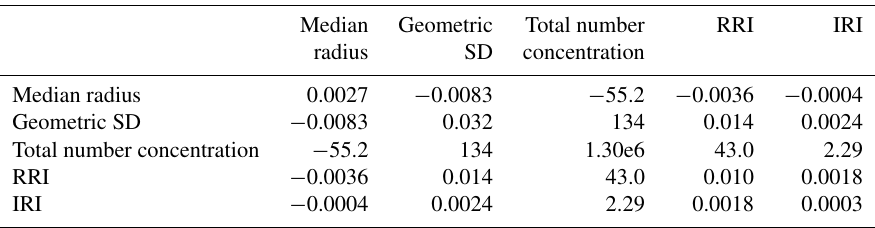
Table 2. Propagated state error covariance matrix for the first reference case, assuming measurement errors of 5% for backscatter and 20% for extinction and a priori covariance as described in Sect. 6 and Table 3.